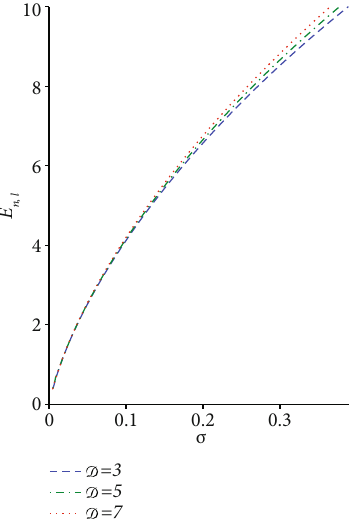
Figure 9: Behavior of the Rényi entropy for the position space S ð R Þ ð δ Þ in terms of the angular momentum quantum number ℓ p with μ = c = ℏ = 1 , Η = 20 , T = 10 , ϱ = 0 : 1 , and σ = 0 : 01 for D = 3